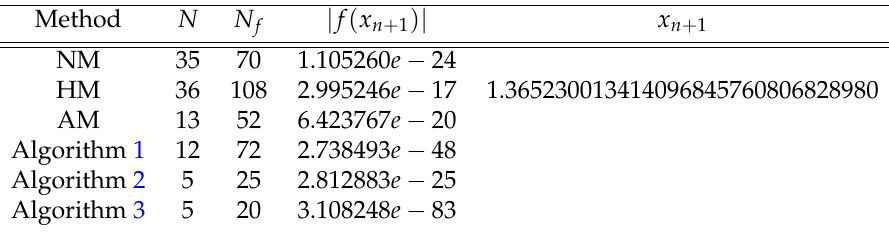
Table 1. Comparison of NM, HM, AM and Algorithms (1), (2) and (3) .